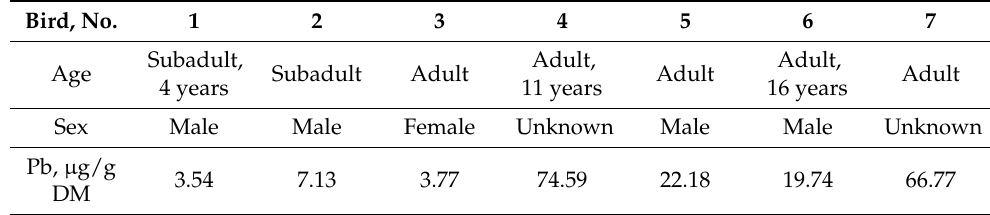
Table 3. Detailed bone Pb levels in tibiotarsi of seven White-Tailed Sea Eagles used for analysis. Bird,